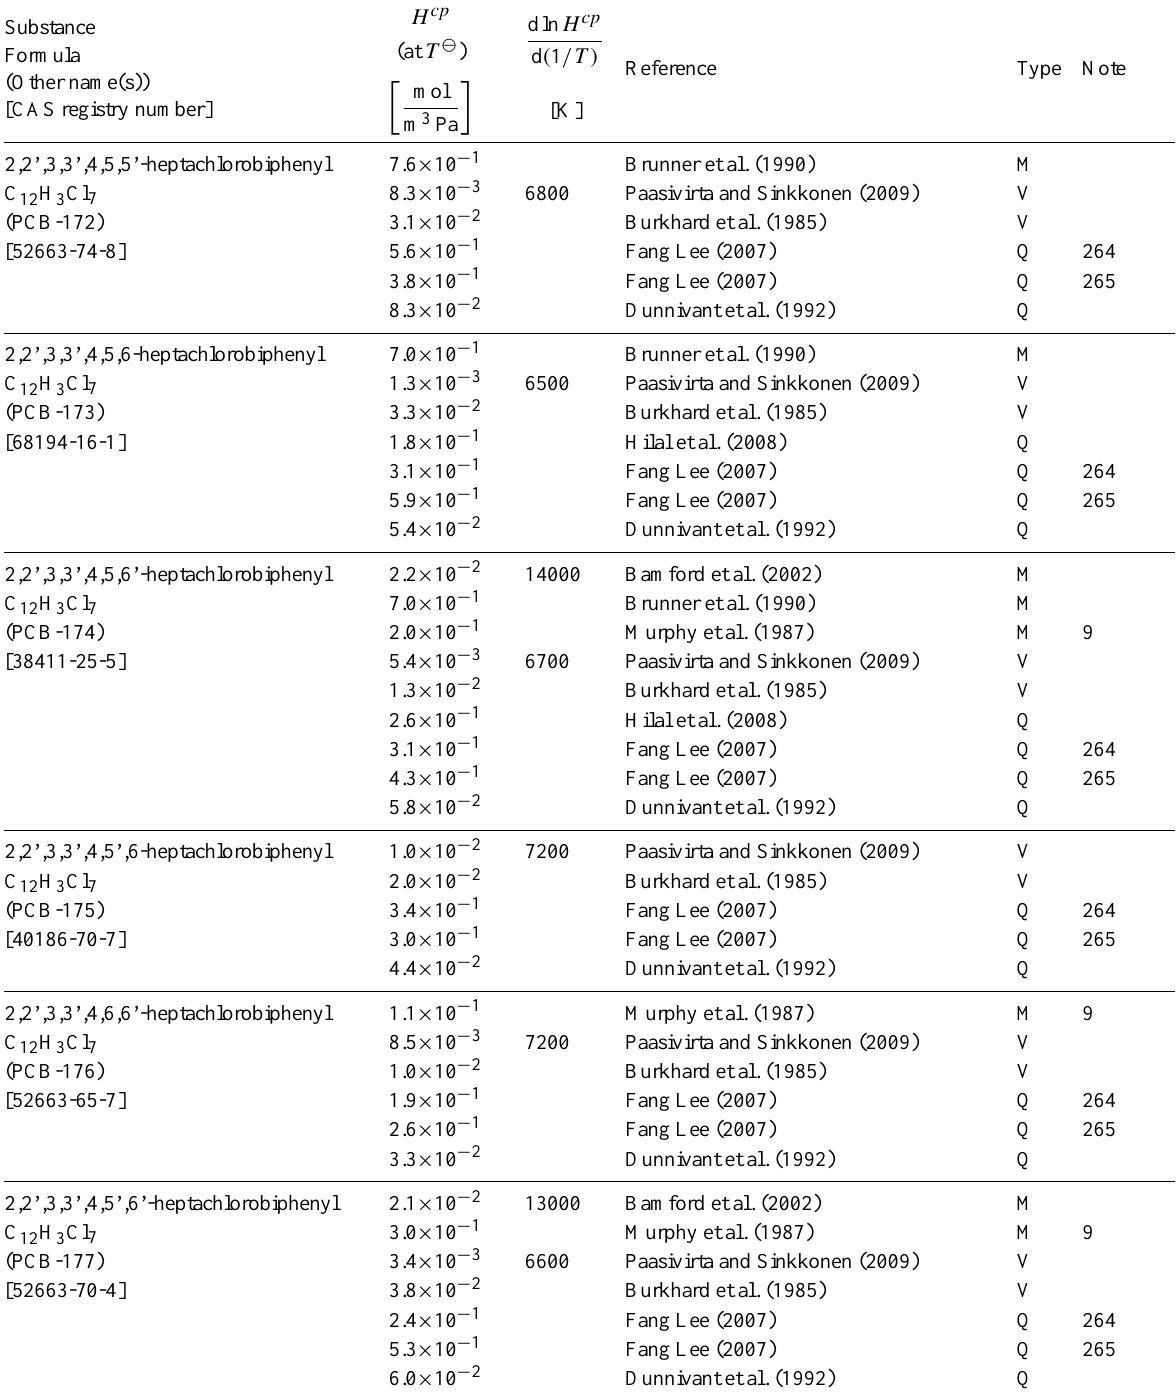
Table 6: Henry’s law constants for water as solvent